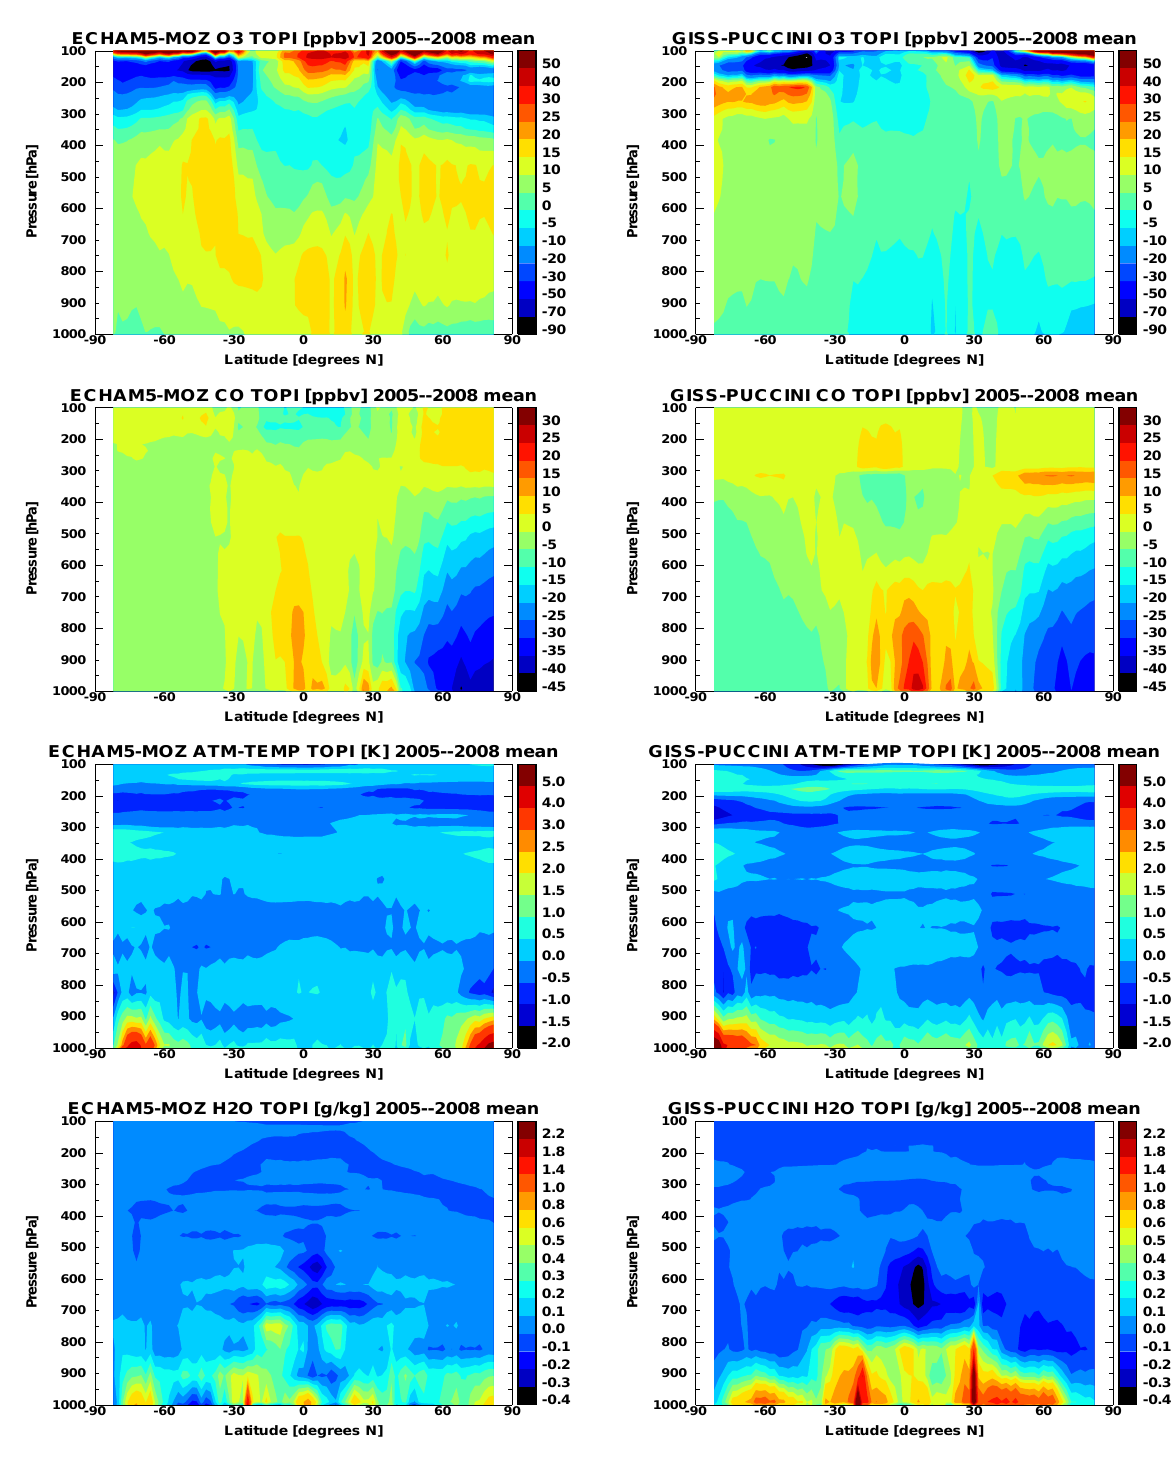
Fig. 9b. The 2005–2008 monthly-mean zonal average absolute error encountered for failure to account for the limited vertical resolution of the nadir satellite. The layout of the figures is similar to those of Fig. 9a for both